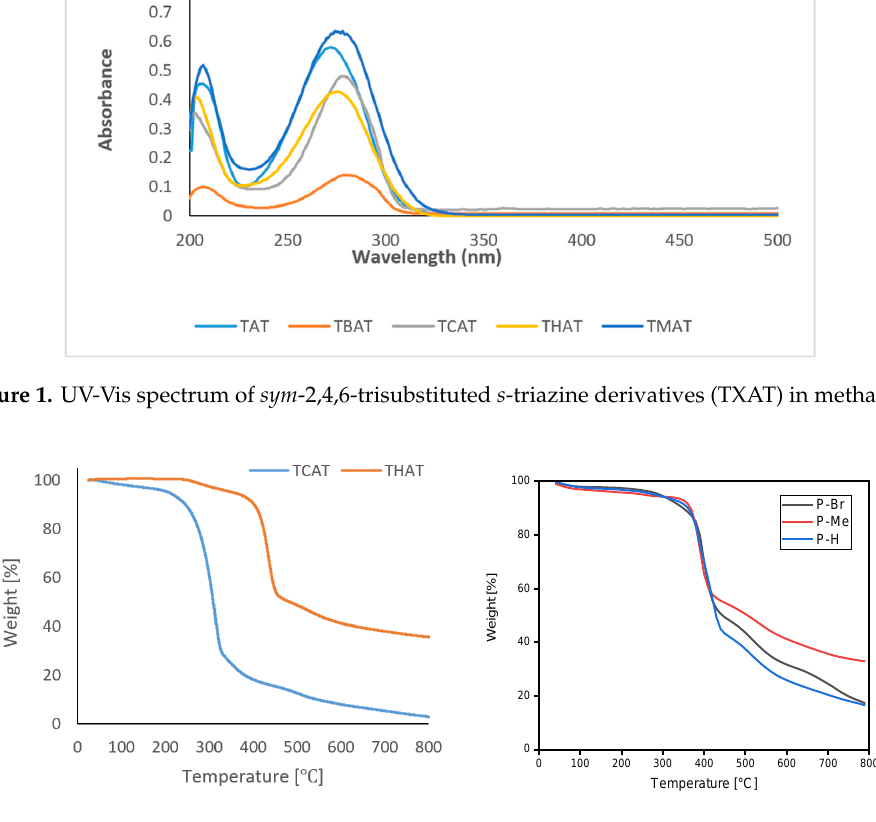
Figure 1. UV-Vis spectrum of sym -2,4,6-trisubstituted s -triazine derivatives (TXAT) in methanol.